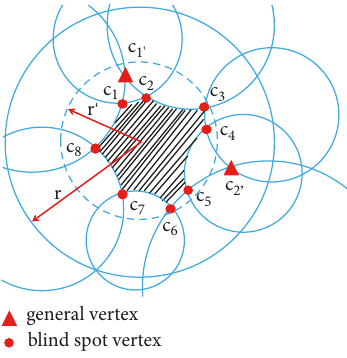
Figure 5: The node 𝑛 𝑖 adjusts the radius of transmission range to cover the blind zone for the purpose of saving the energy and balancing the